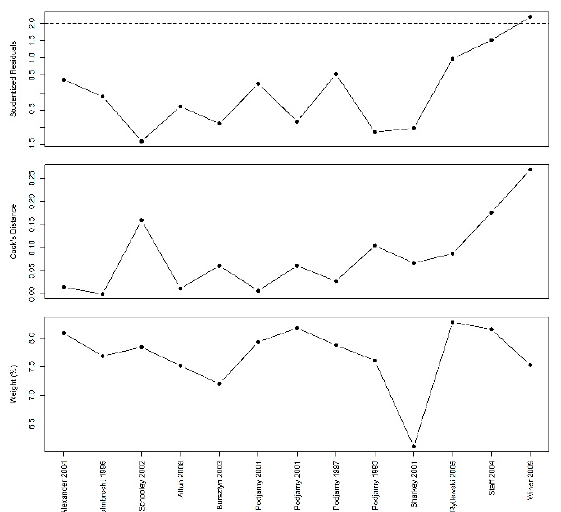
Figure A7. Sensitivity analysis of studies reporting on arginine family supplementation and maternal blood pressure: The sensitivity analysis revealed no clear outlier in studies reporting on arginine family supplementation on maternal blood pressure.